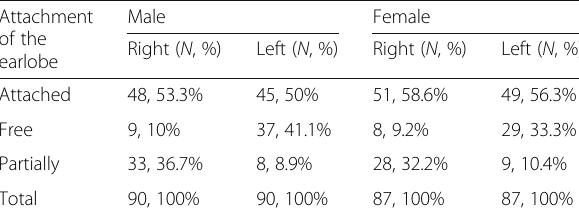
Table 4 Attachment of the earlobe in males ( N = 90) and females ( N = 87) bilaterally Attachment of the